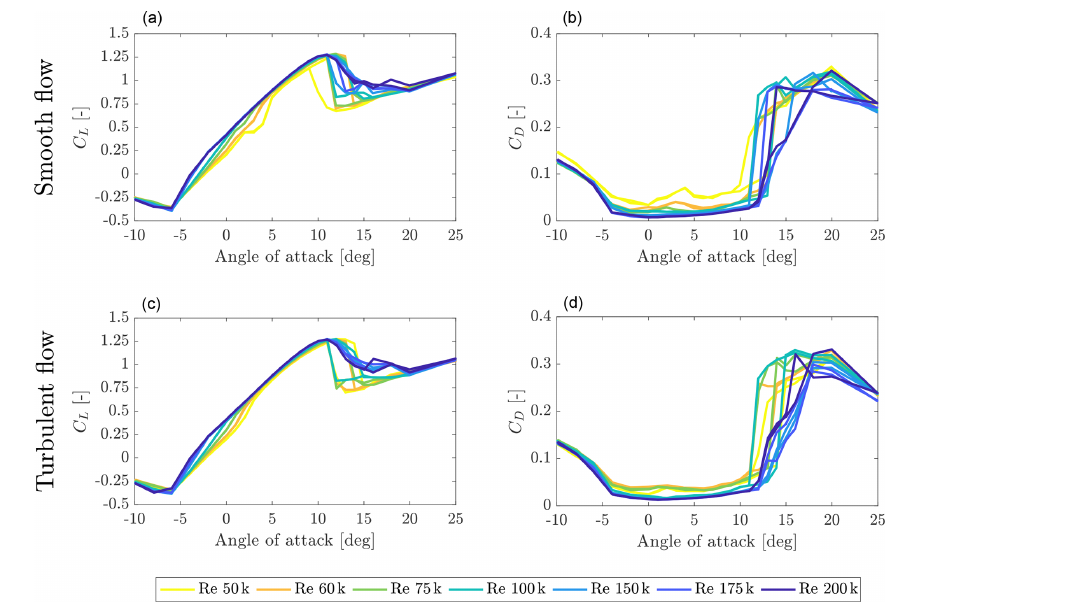
Figure 4. Steady lift ( C L ) and drag ( C D ) coefficients from 2D sectional model tests in smooth flow (a, b) and with added turbulence (c, d)